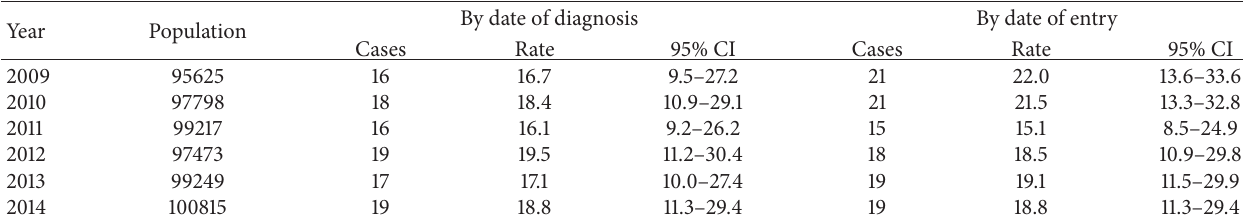
Table 1: T1DM incidence rates (per 100,000) among subjects, 0–18 years of age, in Reggio Emilia province, 2010–2013, by date of diagnosis and by date of